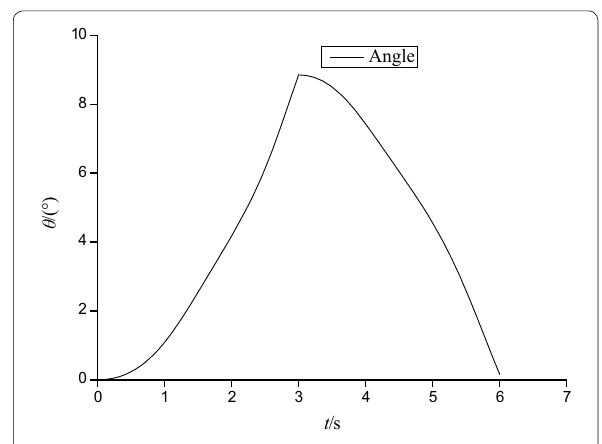
Figure 10 Hydraulic cylinder swing angle This represents the piston rod output precision dis- placement curve. In the absence of the proposed asym- metric static-pressure control system, friction occurs between the piston rod and guide sleeve. There is also a lesser degree of friction between the piston and cylinder.